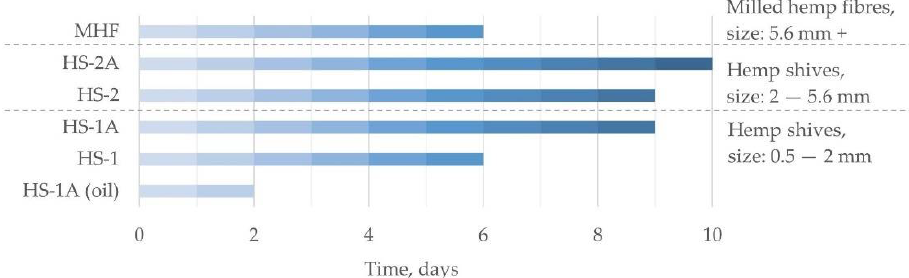
Figure 5. Amount of time until hemp board samples decay in